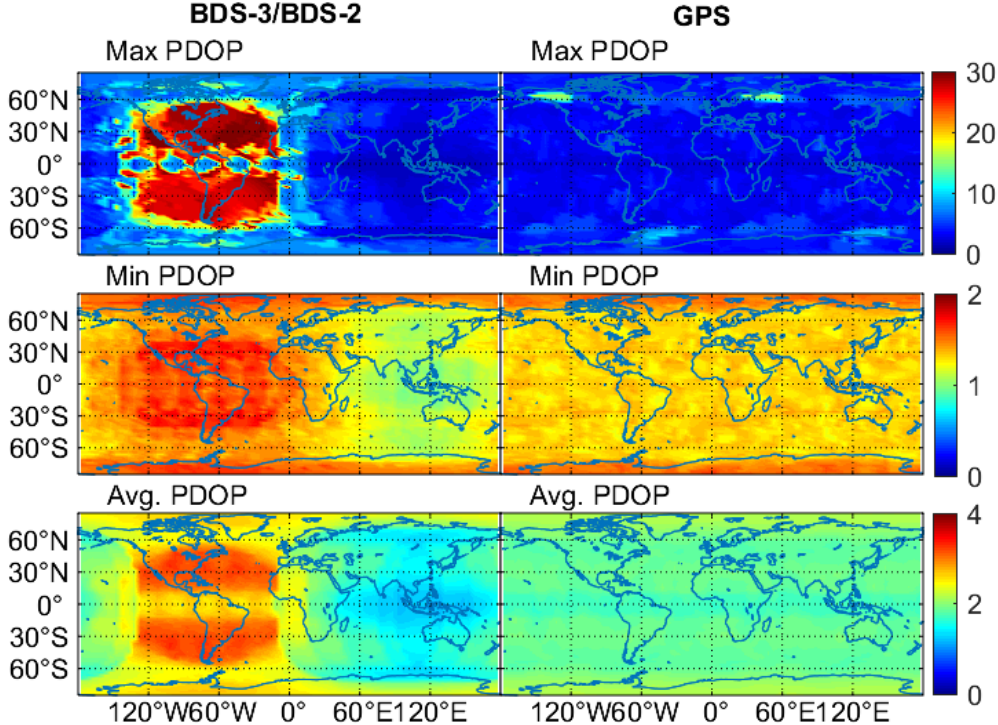
Figure 5. Global maps of the maximum, minimum and average position dilution of precision (PDOP), values for BDS-3 / BDS-2 and GPS on DOY 140–146 of